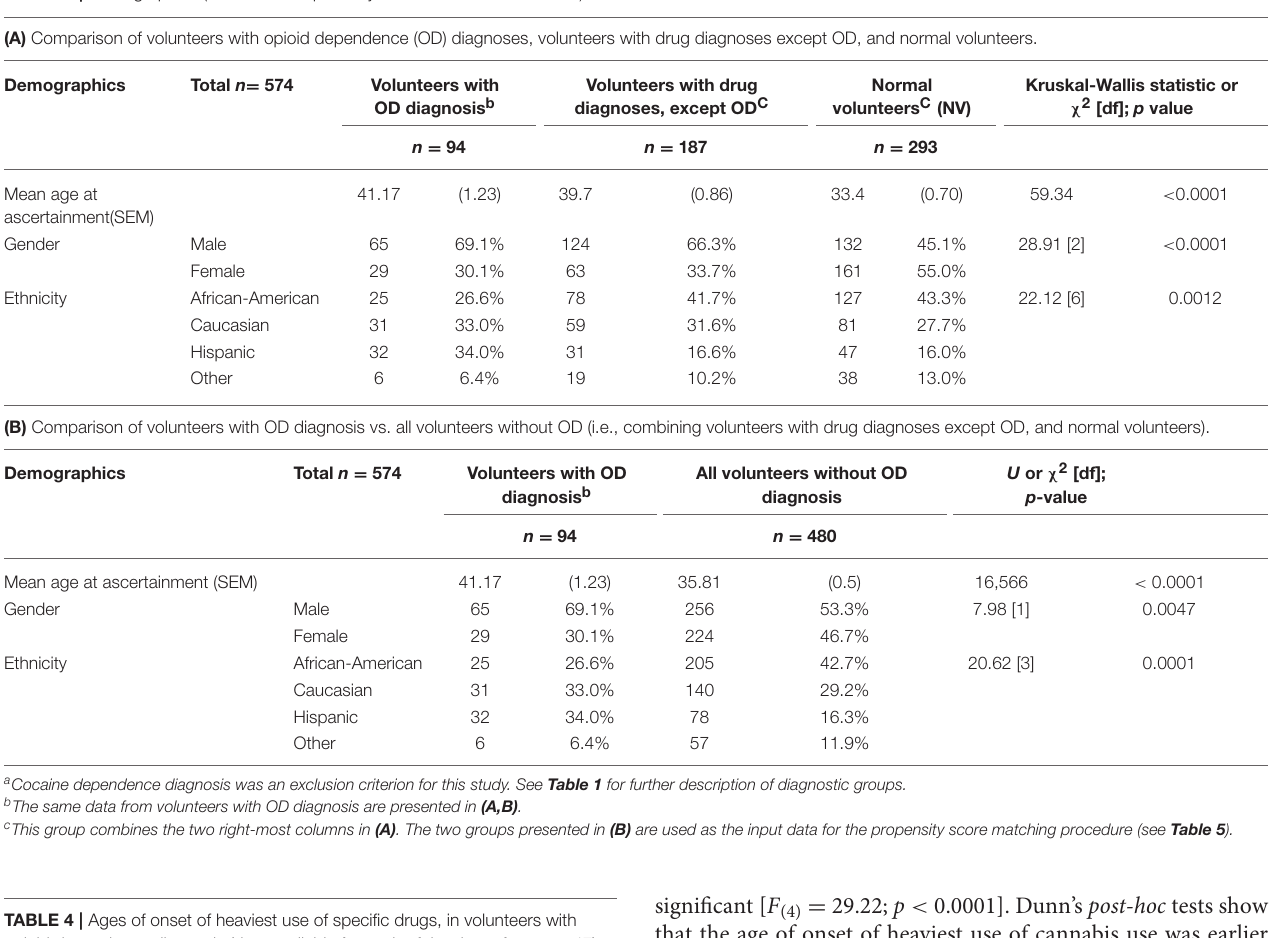
TABLE 4 | Ages of onset of heaviest use of specific drugs, in volunteers with opioid dependence diagnosis (data available for each of the drugs from n = 47).